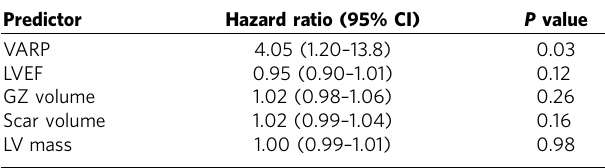
Table 1 | Hazard ratios for the primary end point.